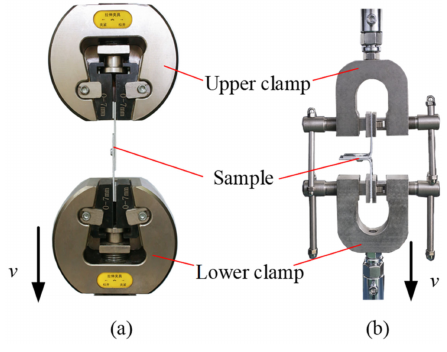
Figure 5. Tests of ( a ) shear and ( b ) peel.